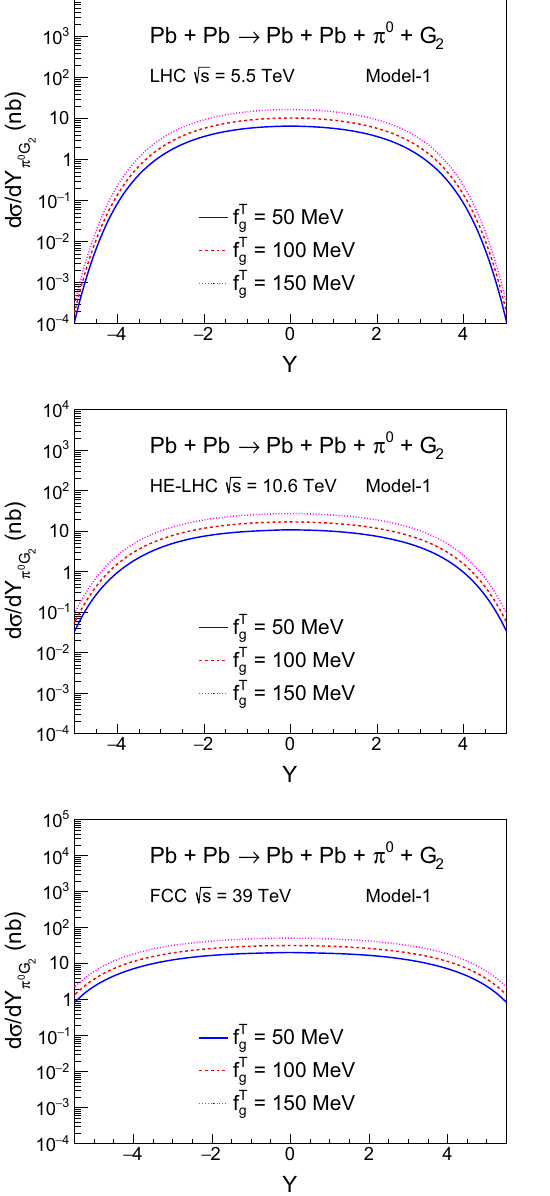
[40,41]. The table includes the results of both model-1 and model-2 calculations. Here we set the previously mentioned coupling